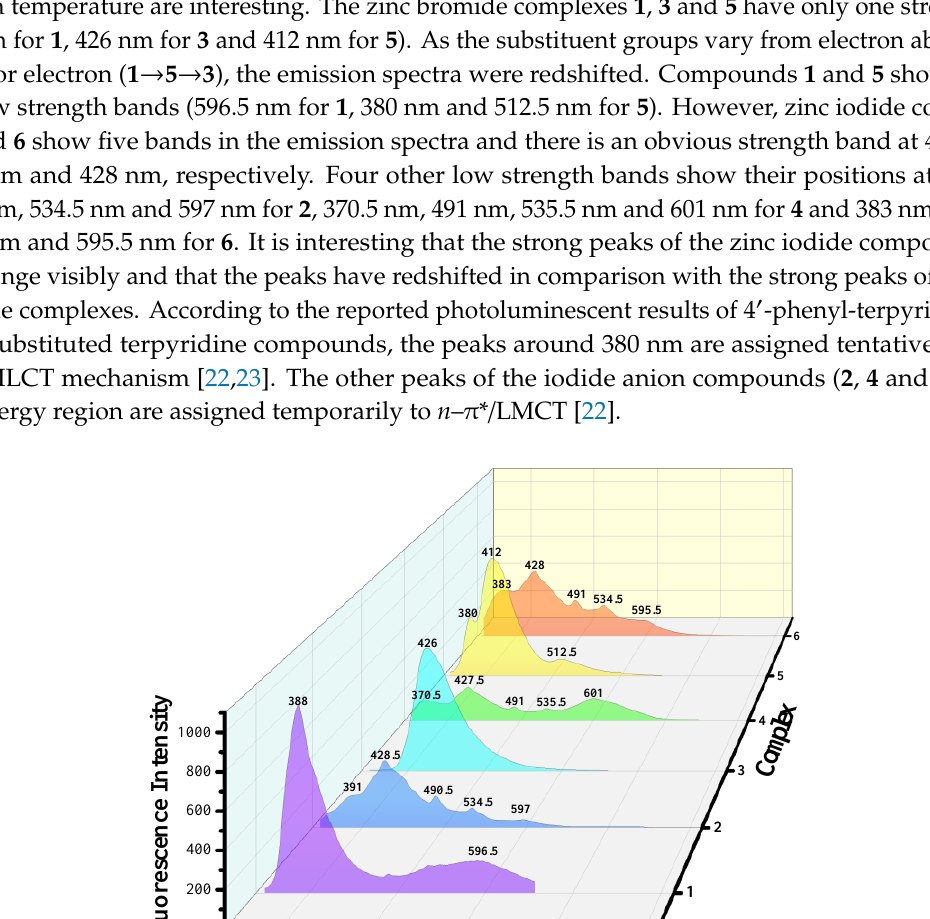
( b ) Figure 3. The UV-vis spectra of complexes ( a ) 1 and ( b ) 3 in PBS buffer solution over a period of 72 h. 2.5. Antiproliferative Activity and Toxicity Studies The in vitro antiproliferative properties of complexes 1 – 6 against Eca-109, A549 and Bel-7402 tumor lines were examined by employing the CCK-8 assay with cisplatin as a positive control. As seen from Figure 4, all the complexes display a dose-dependent manner on the viability of the test cells. Table 1 shows the IC 50 values of the compounds in the range of 0.066–0.945 μM, which is significantly lower than that of cisplatin (5.66–11.45 μM). It is interesting that the different cells respond distinctively to these complexes. The complexes display remarkable cytotoxicity against Eca-109 in comparison to A549 and Bel-7402. Notably, the antiproliferative activity of 1 and 2 is better than that of the other compounds towards the three cell lines and, when the para-substituent is the same, the activity of the iodide anion